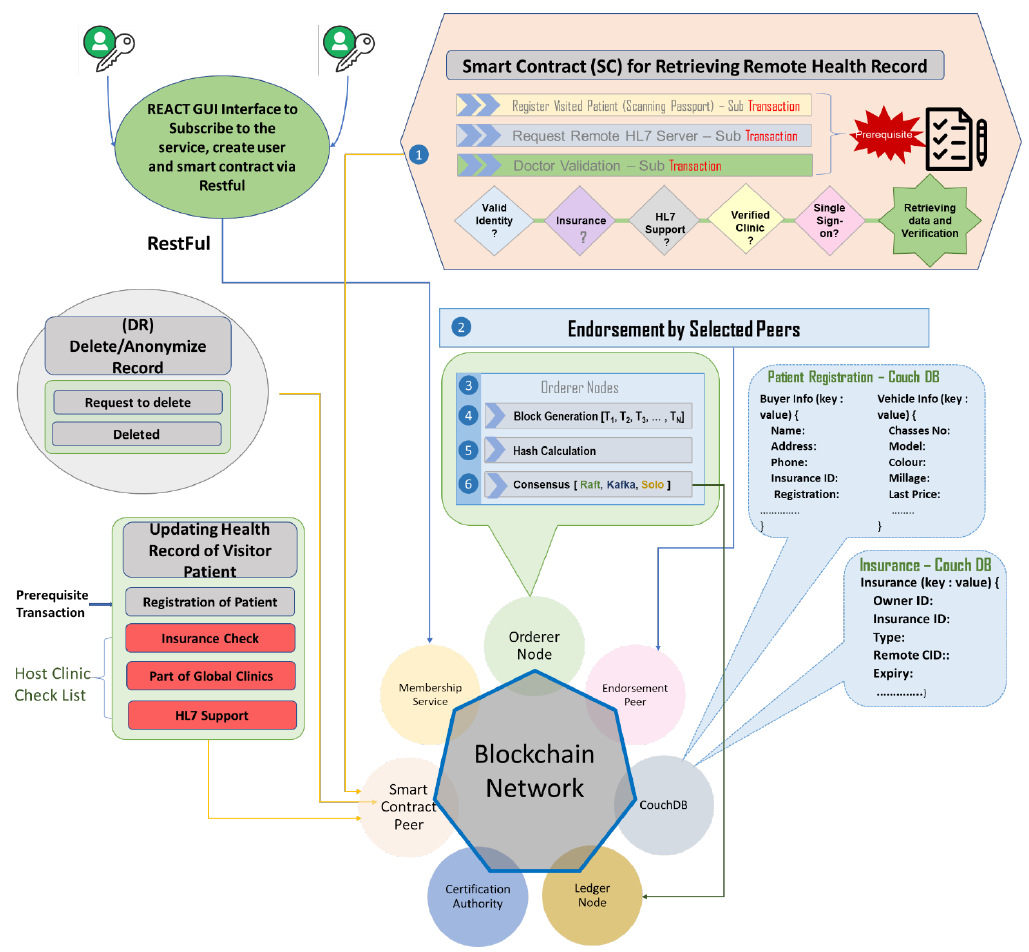
Figure 9. Complete implementation diagram.